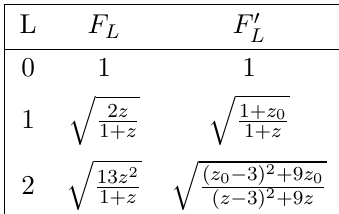
Blatt-Weisskopf form factors for angular momentum L = 0 ; 1 ; 2 with two distinct